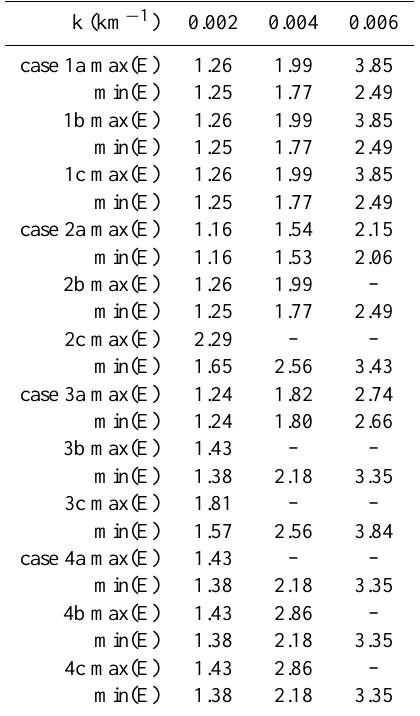
Table 2. Enhancement parameter for the twelve spectra in Figs. 6 to 9 in the maximum and the minimum distortion directions.